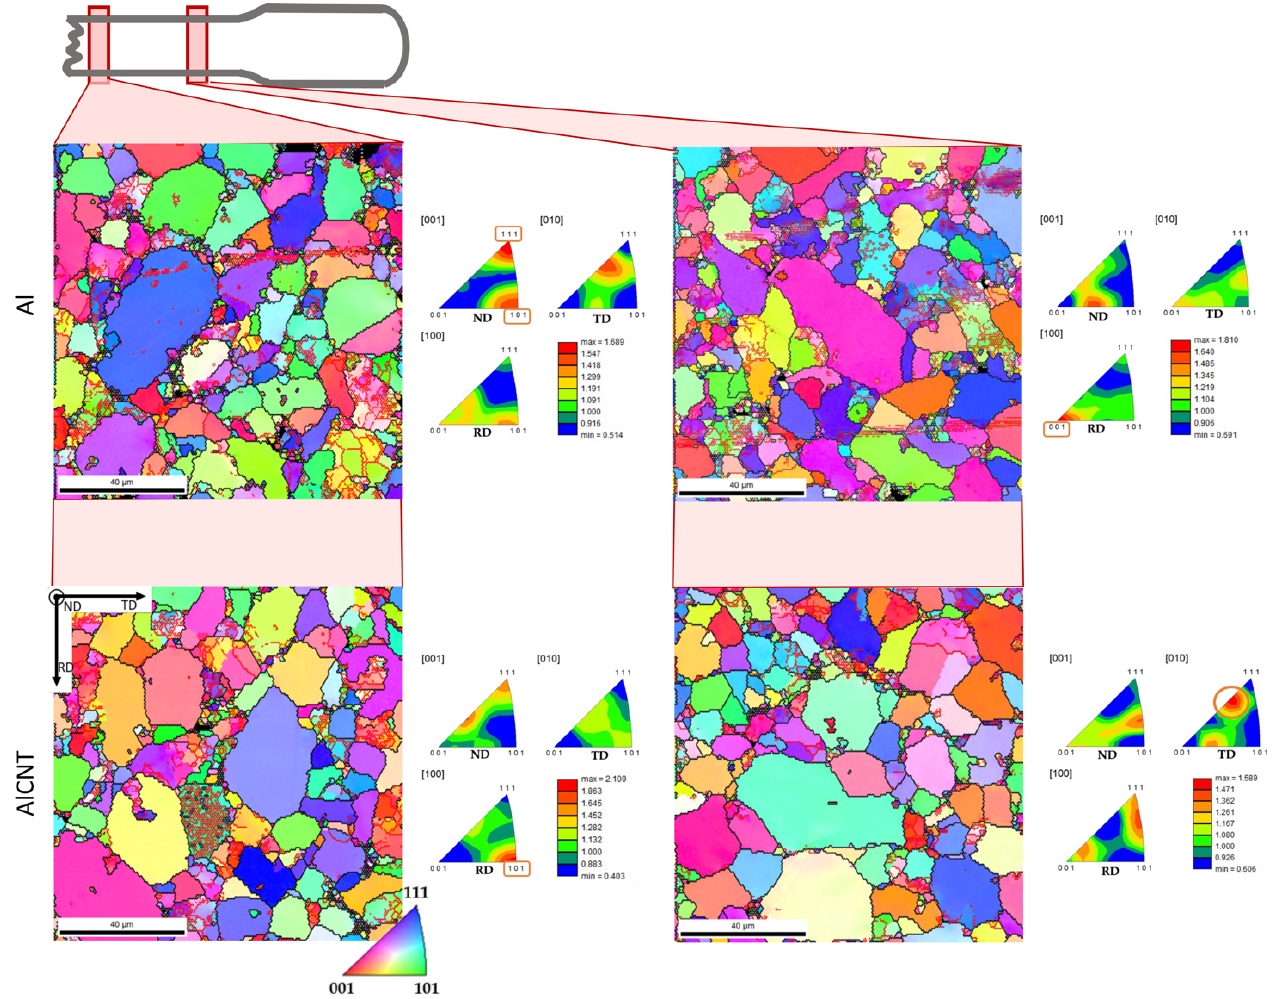
Figure 14 . Inverse pole figure (IPF) maps, with high-angle (black) and low-angle (red) boundaries and the correspondent IPFs of Al and Al/CNT samples at 2.0 mm and 10.0 mm from the fracture surface.